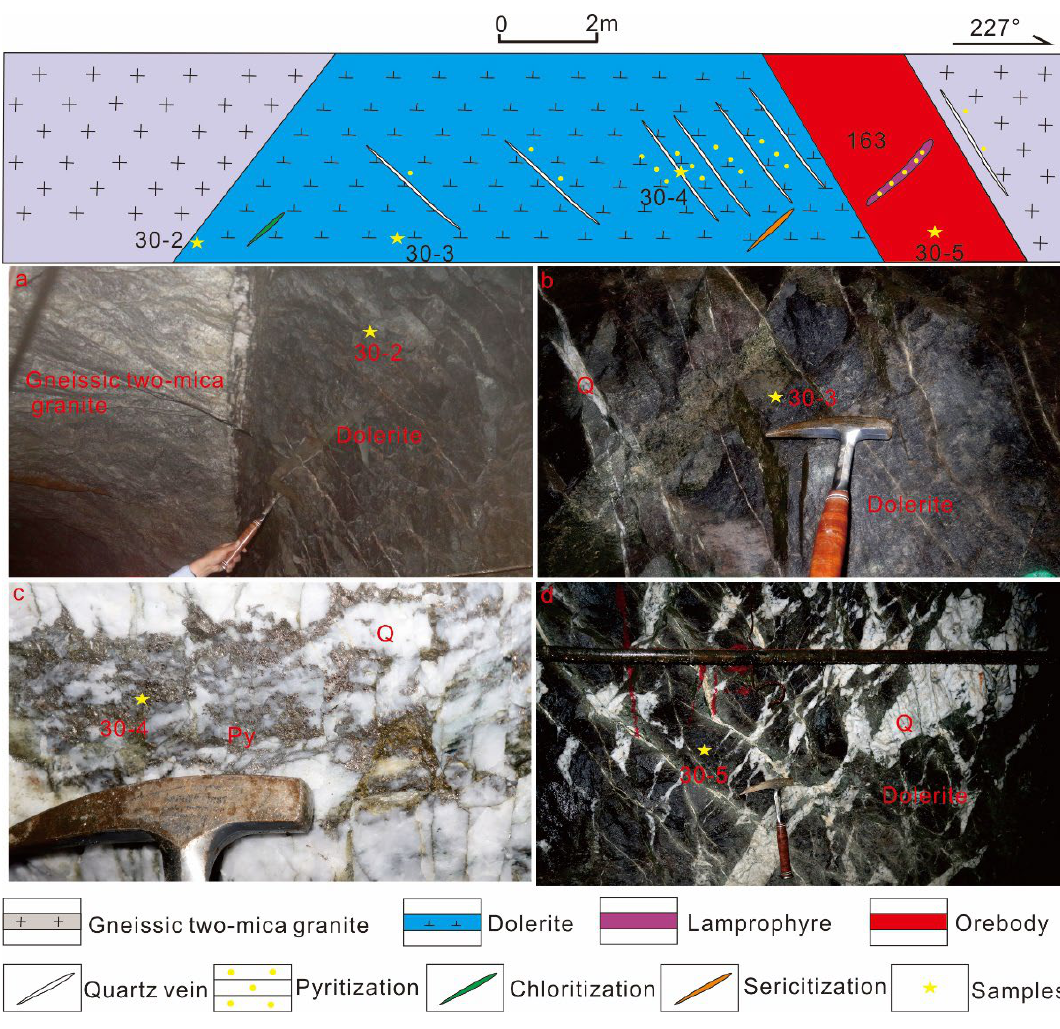
Figure 5. Spatial alteration features in a typical field profile of underground tunnels at −756 m level. ( a ) The boundary between gneissic two-mica granite and dolerite; ( b ) The intensity of silicification is weak in diorite; ( c ) Pyrite in ore; ( d ) The intensity of silicification is strong in diorite. Abbreviations: Py—pyrite; Q—quartz.